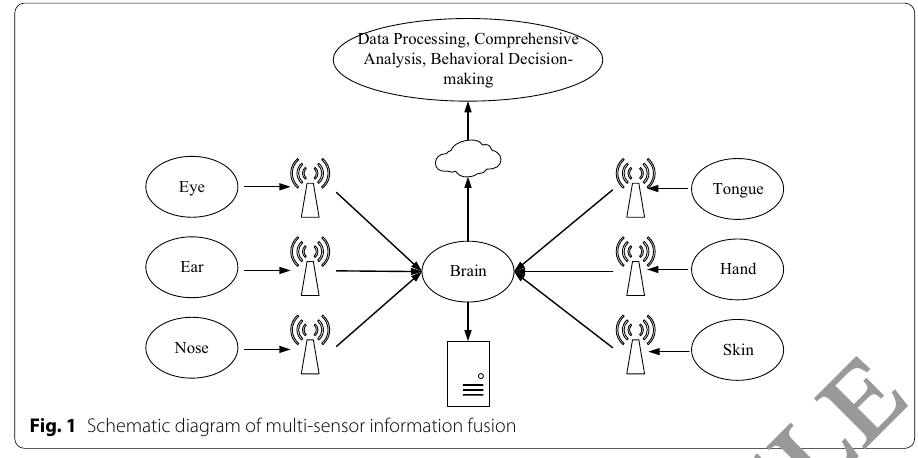
Fig. 1 Schematic diagram of multi-sensor information